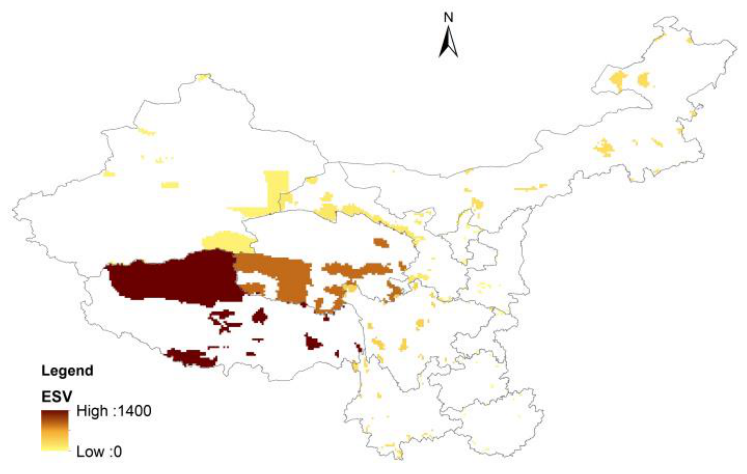
Figure 10. Ecosystem services values in the national nature reserves of western China in 2005.